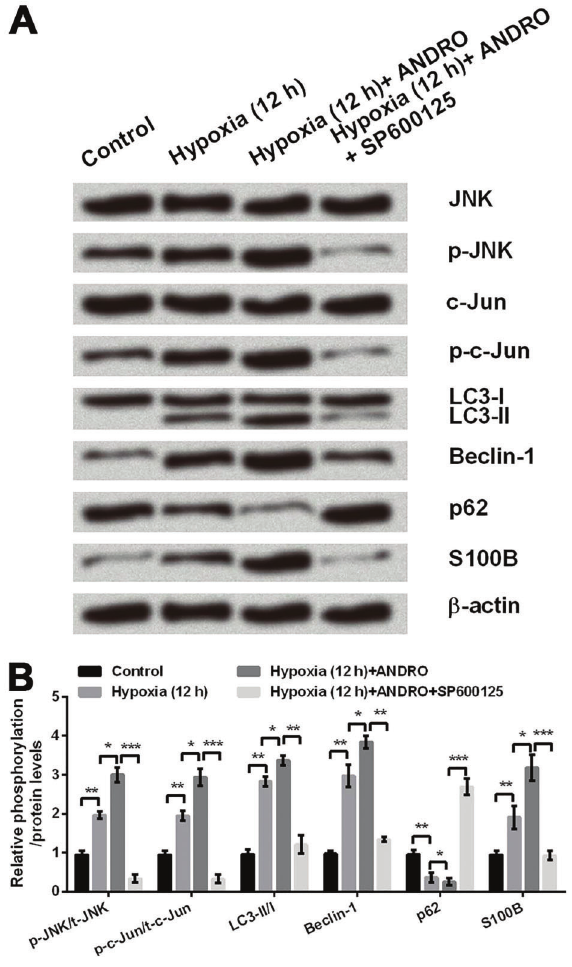
Figure 5. A , Protein immunoblots of S100B and proteins related to JNK pathway and autophagy measured by western blot in hypoxic astrocytes with or without treatment of andrographolide (ANDRO) and SP600125. B , Relative expressions of JNK path- way and autophagy related factors by quanti fi cation of band intensity. b -actin acted as an internal control. Data are reported as means ± SD. *P o 0.05, **P o 0.01, ***P o 0.001 (ANOVA).